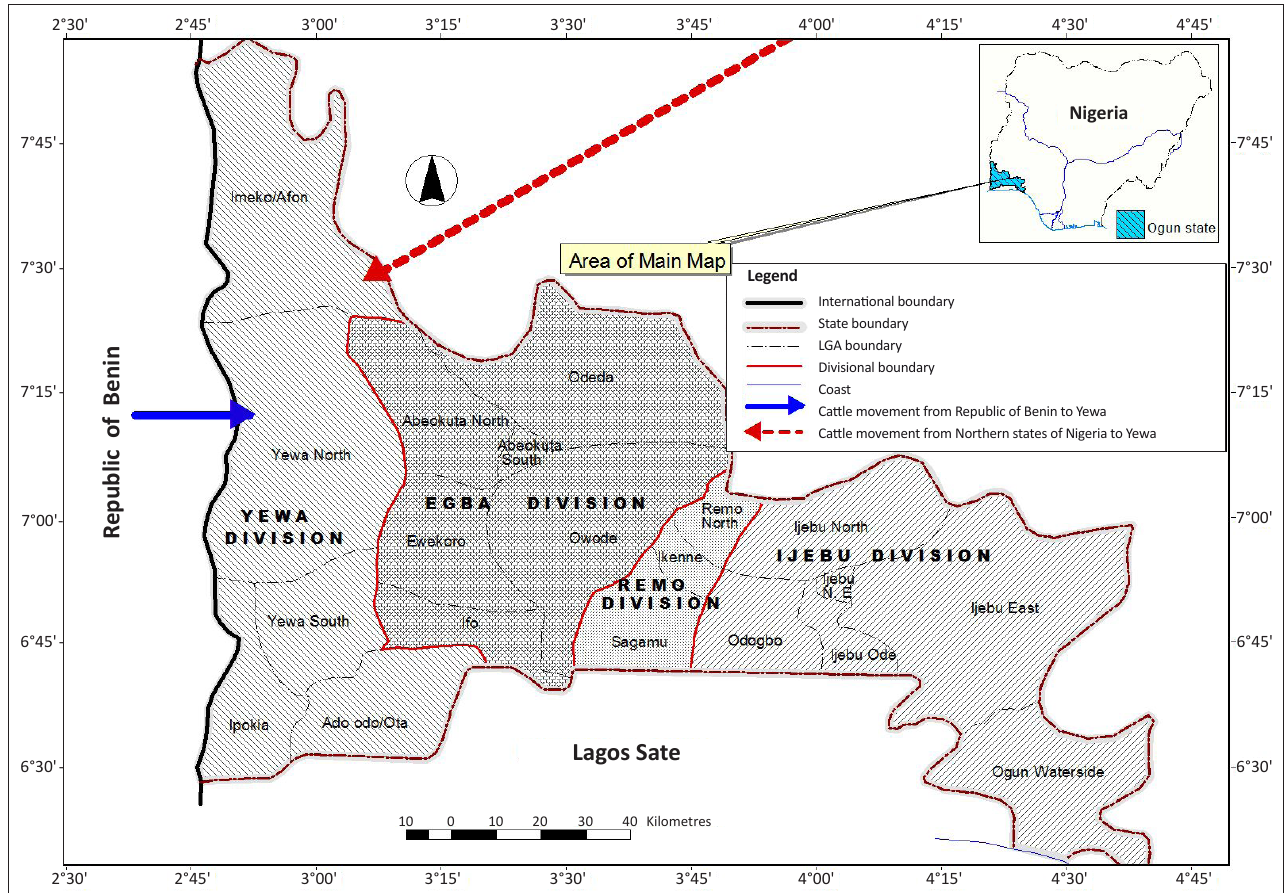
FIGURE 1: Map of Ogun State, showing different geopolitical regions.